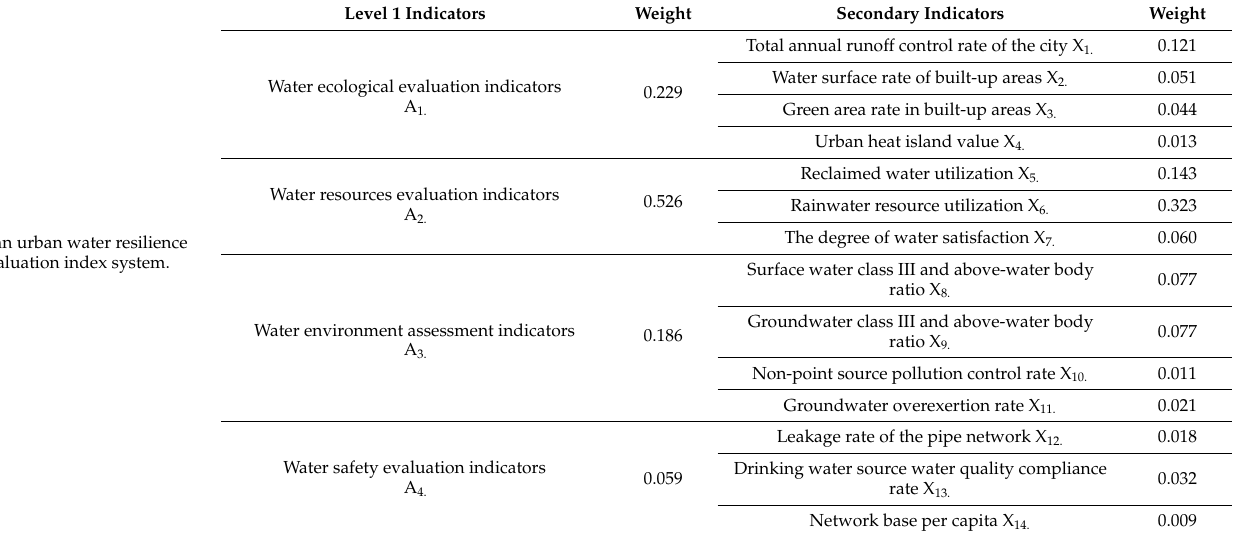
Table 6. Weights of water resilience evaluation model in